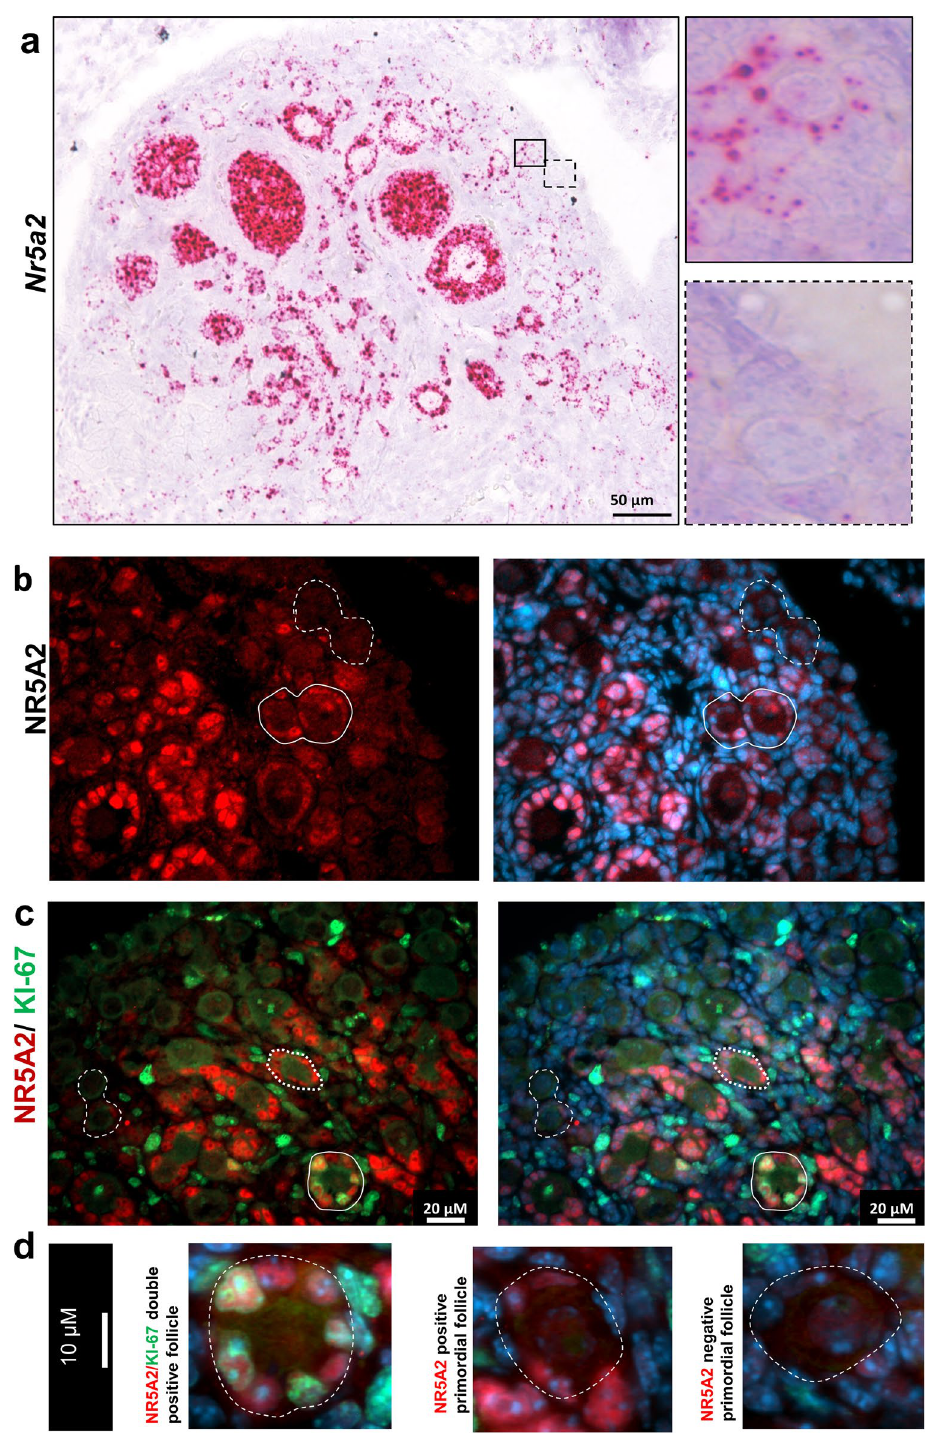
Figure 3. NR5A2 defines two subsets of primordial follicles. ( a ) RNA in situ hybridization of Nr5a2 in CON mouse ovaries at PND6. Panels at right demonstrate two types of primordial follicles, one that expresses NR5A2 (red signal). ( b ) Immunolocalization of NR5A2 in the ovaries of PND3 CON mice. The left panel displays immunolocalization of NR5A2 (red), while the right panel shows NR5A2 and the nuclear stain, DAPI (blue). The dashed line indicates follicles lacking NR5A2, while the solid line designates follicles with NR5A2 expression. To the right are larger images of the example follicles of interest. ( c ) Immunolocalization of NR5A2 (red) and KI-67 (green) in the ovaries of PND3 CON mice. The dashed line indicates primordial follicles without the NR5A2 signal, the dotted line indicates a primordial follicle expressing NR5A2 but not KI-67, and the solid line indicates primary follicles expressing both NR5A2 and KI67. ( d ) High magnification images of (from left to right) an NR5A2, KI67 double positive primary follicle, an NR5A2 positive, KI67 negative primordial follicle, and an NR5A2, KI67 negative